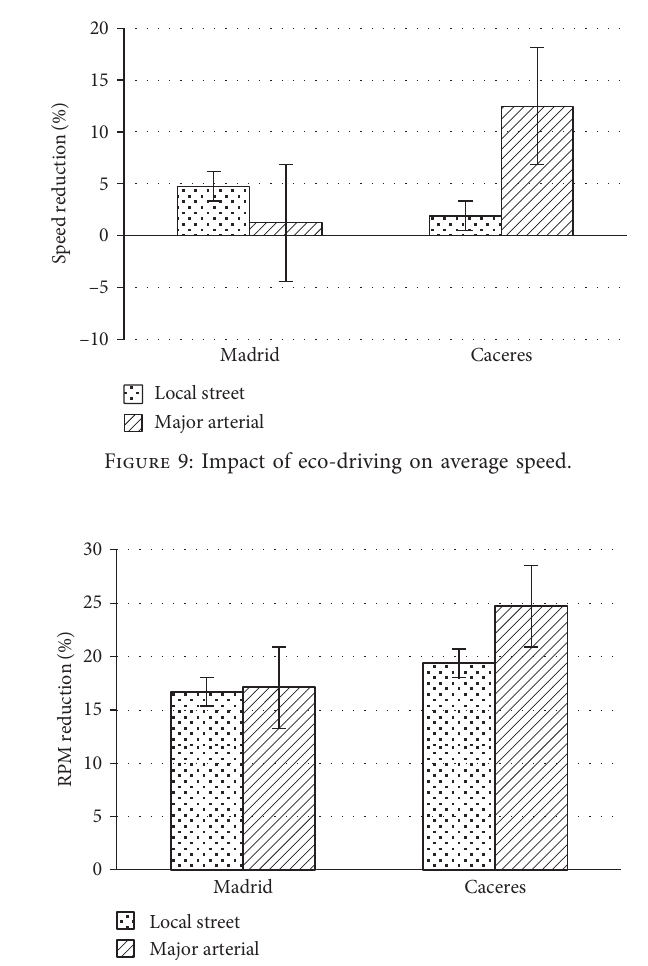
Figure 10: Impact of eco-driving on average rpm.